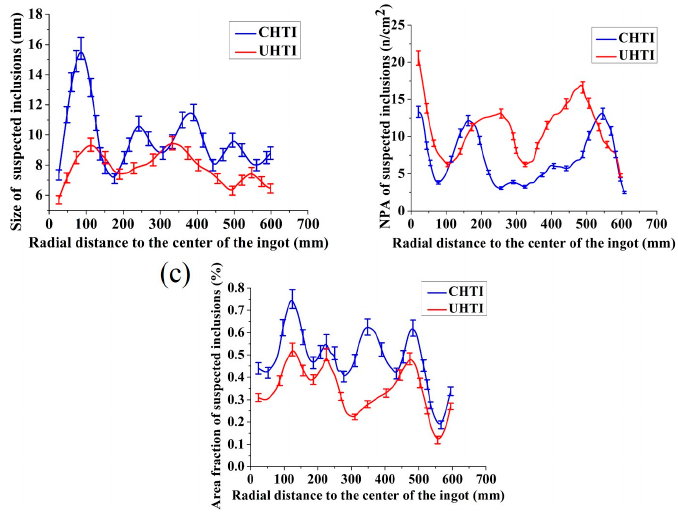
Figure 4. OM microstructure of different parts of the two ingots. ( a – c ) edge, ½ radius, center of CHTI; ( d – f ) edge, ½ radius, center of UHTI.